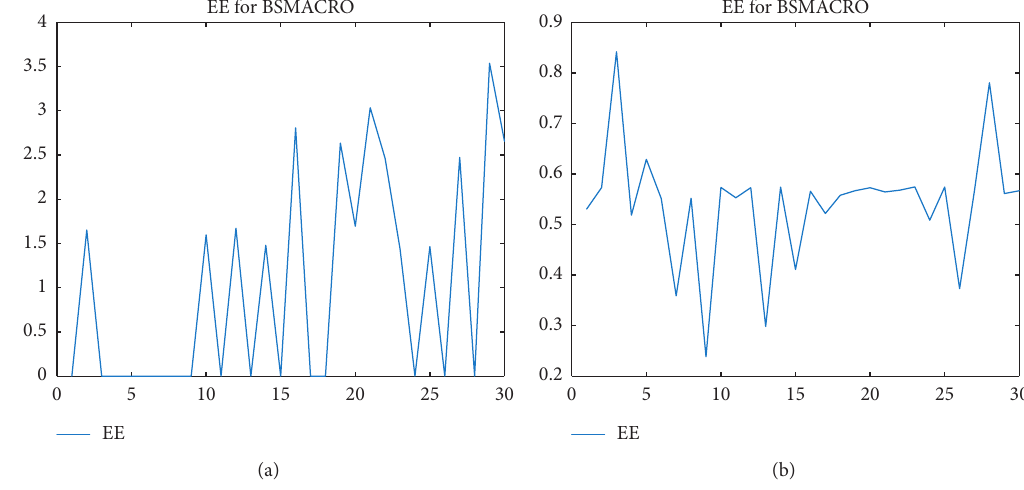
Figure 2: The energy efficiency (a) and SINR (b) of macro BS for 30 MUE.